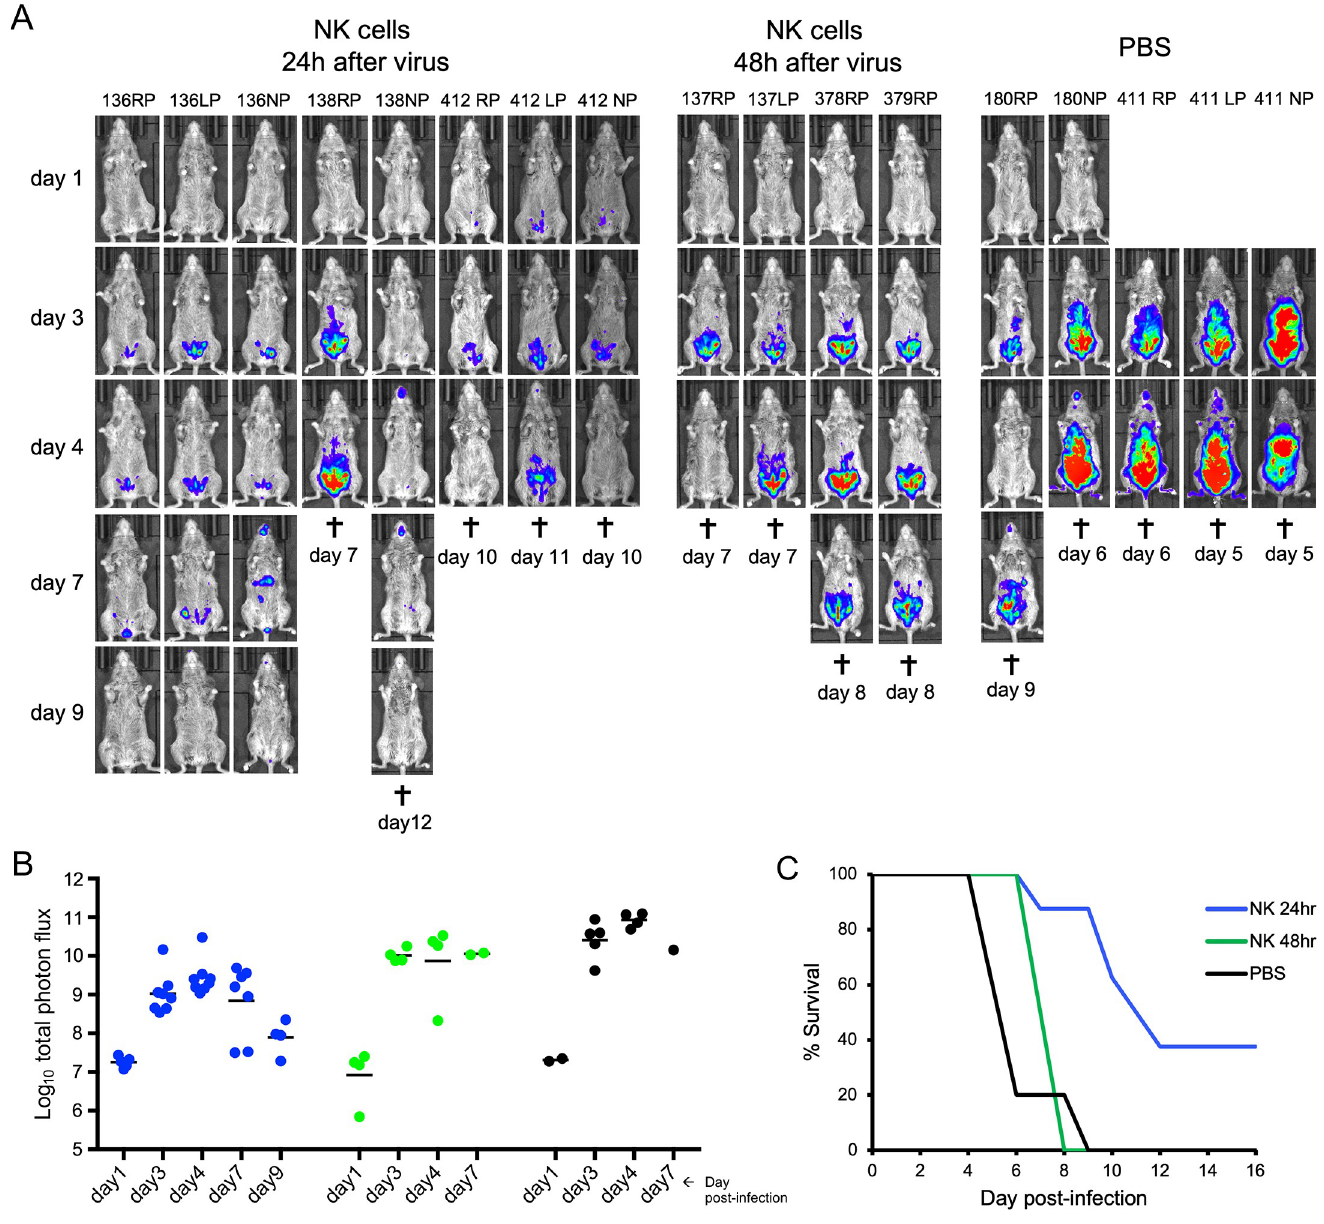
Fig 8. Passive transfer of activated NK cells following VACV infection. (A) Data are compiled from two separate experiments. In the first experiment, CAST mice were infected IP with 655 PFU of VACV expressing FLuc. After 24 or 48 h, 4 to 5 mice were inoculated IP with 3.1x10 6 activated NK cells. Two mice received PBS instead of NK cells as a control. In the second experiment, CAST mice were infected with 550 PFU of VACV and after 24 h, 3 mice (412RP, 412LP, and 412NP) were inoculated with 3.0 X 10 6 activated NK cells and 3 mice (411RP, 411LP and 411NP) received PBS. Virus spread was determined by luminescence as in Fig 2. Ventral images of individual mice are shown. (B) The total photon flux for individual animals are shown. The difference between the 8 mice receiving NK cells at 24 h after infection versus the 5 PBS controls was significant on days 3 and 4 after infection (p = 0.0031 and 0.004, respectively). (C) Days of death or euthanasia (†) and survival curves for the two experiments are shown. The time to death between the mice receiving NK cells at 24 h after infection and PBS controls was significant (p = 0.022, determined by Mantel-Cox